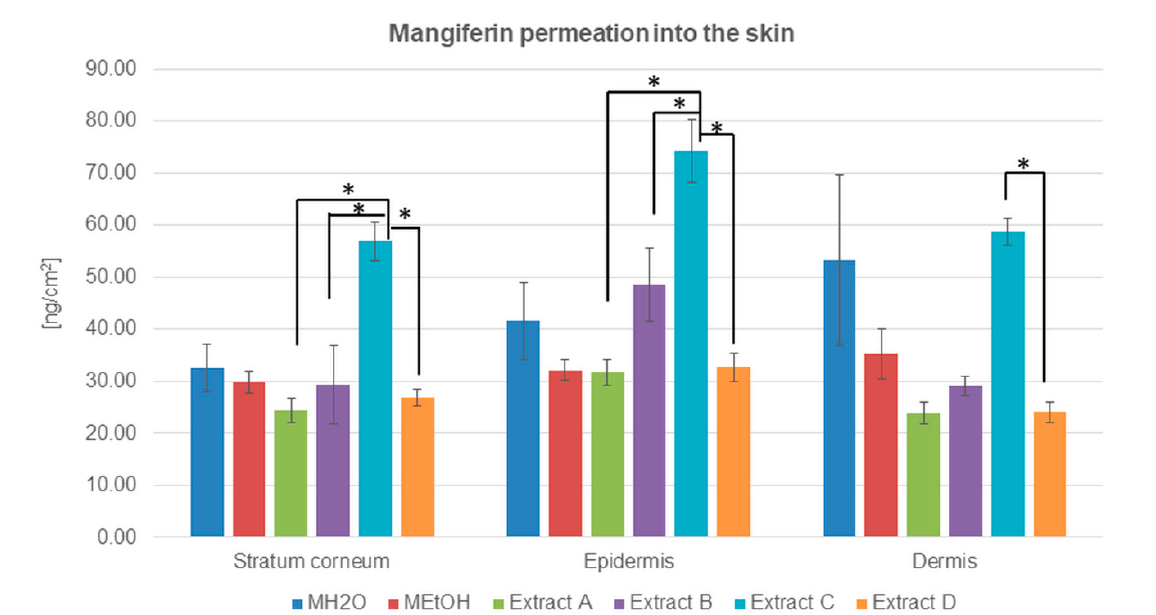
S.c. stratum corneum; each average value was obtained from three independent repetitions.